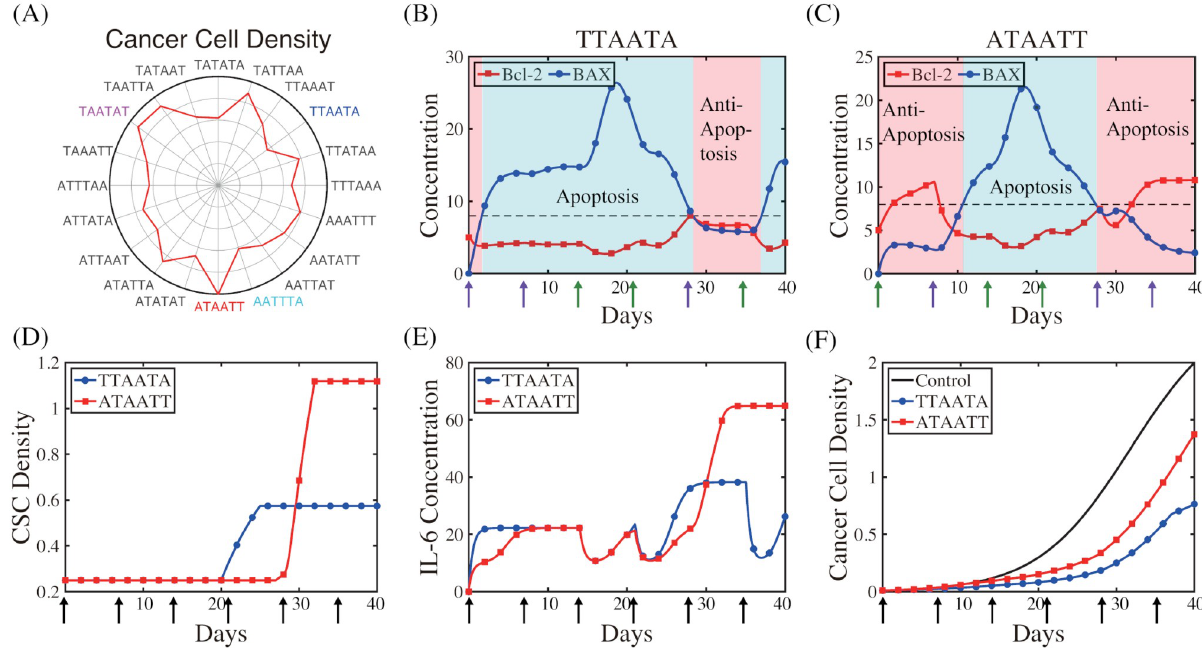
Fig 12. Optimized schedule: Maximizing anti-tumor efficacy. (A) Polar representation of the normalized cancer cell population at t = 40 days corresponding to the different alternating schemes of TZB and ATV. (B,C) Time courses of the Bcl-2 and BAX levels corresponding to the best (‘ TTAATA ’ in (B)) and worst (‘ ATAATT ’ in (C)) scheme. (D-F) Time courses of the CSC density (D), IL-6 concentration (E), and cancer cell density (F) corresponding to two schemes in (B,C). Parameters: I = 3.3, I = 0.075. Other parameters are given in Table 1. A T